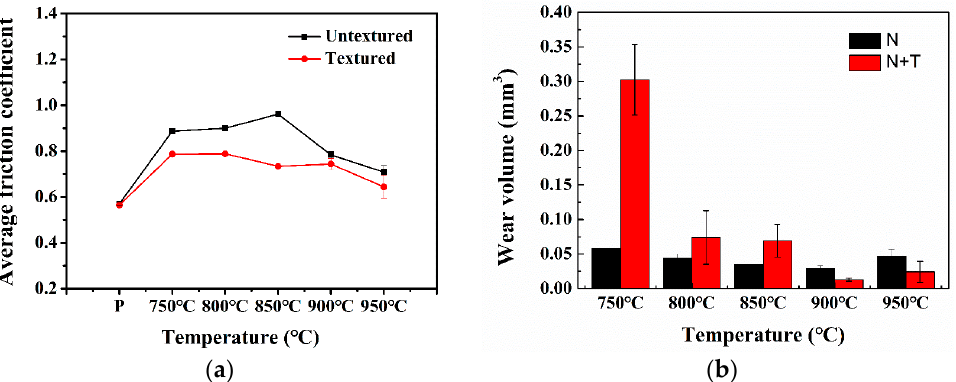
Figure 7. ( a ) Friction coefficient and ( b ) wear volume after nitriding and nitriding/texturing duplex treatment at different nitriding temperatures.